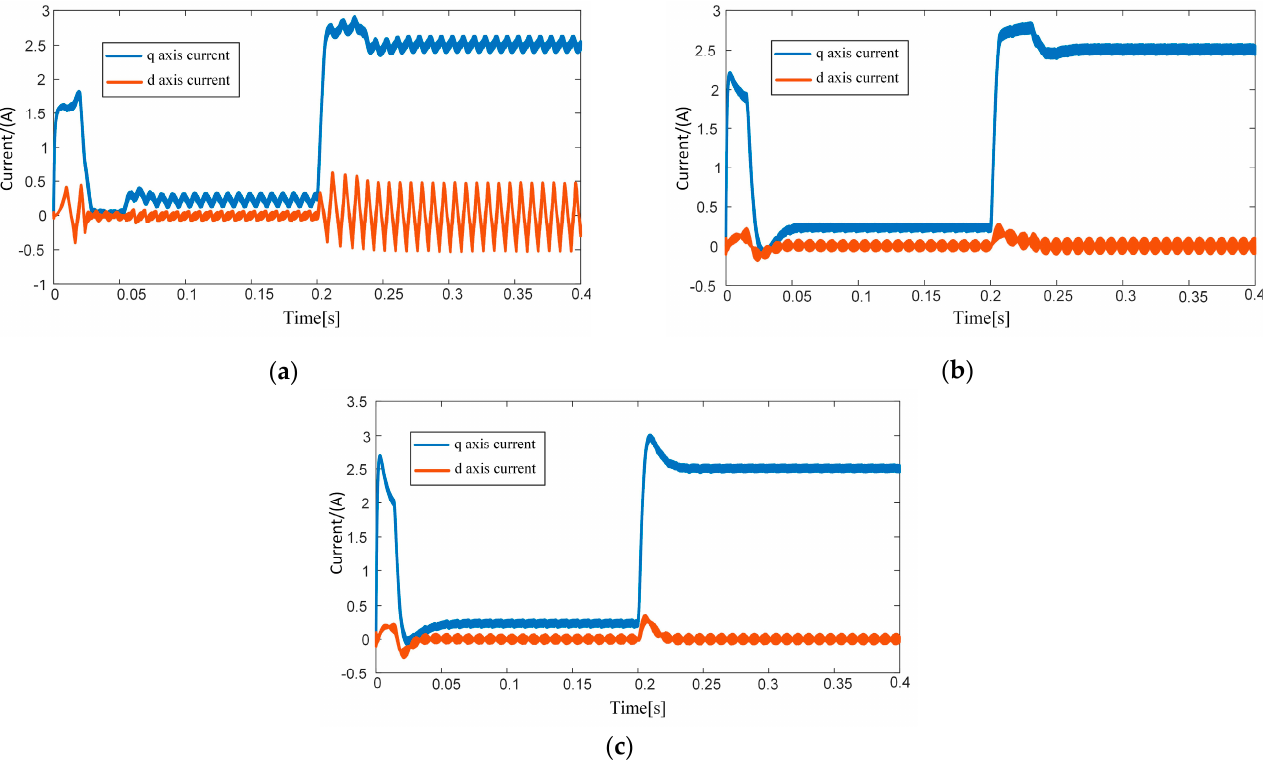
Figure 12. d-q axis current waveform: ( a ) The traditional sliding mode; ( b ) the traditional sliding mode + dead zone compensation; ( c ) adaptive sliding mode observer + dead zone compensation.